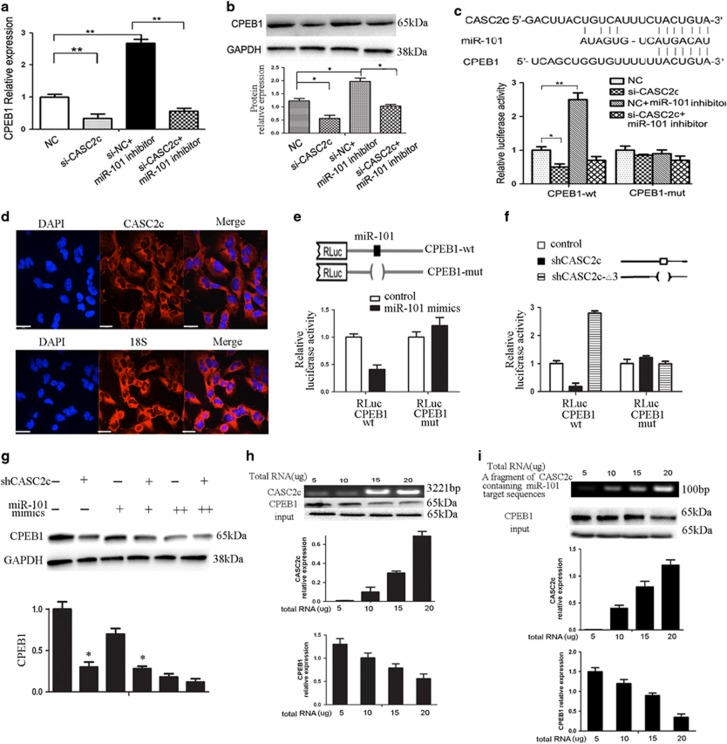
CASC2c competes to combine miR-101 by repelling CPEB1. (a or b) The expression of miR-101 was analyzed through real-time qPCR (a) and western blot (b) in si-CASC2c, miRNA-101 inhibitor or miRNA-101 inhibitor-transfected U251 cells. Data presented as mean±S.E.M. of three independent experiments; *P<0.05, **P<0.01. (c) Upper, nucleotide resolution of miRNA-binding sites in CASC2c and CPEB1. Below, relative fluorescence activity in U251 cells co-transfected with pMIR-REPORT-WT/mutant 3′-UTR CPEB1 and miR-101 inhibitor or negative control, pMIR-REPORT-WT/mutant 3′-UTR CPEB1, si-CASC2c and miR-101. Data presented as mean±S.E.M. of three independent experiments; *P<0.05, **P<0.01. (d) RNA fluorescence in situ hybridization showing the localization of CASC2c, the nucleus is counterstained with DAPI. Scale bar, 29μm. (e) Relative fluorescence activity in U251 cells co-transfected with RLuc-CPEB1-wt or RLuc-CPEB1-mut and miR-101 ncor miR-101 mimics. Data presented as mean ±S.E.M. of three independent experiments; *P<0.05, **P<0.01. (f) Relative fluorescence activity in U251 cells co-transfected with RLuc-CPEB1-wt or RLuc-CPEB1-mut and shCASC2c or shCASC2c-△3 plasmid. Data presented as mean±S.E.M. of three independent experiments; *P<0.05, **P<0.01. (g) The expression of CPEB1 was analyzed through western blot in U251 cells transfected with different combinations of shCASC2c and miR-101 mimics. (+) corresponds to 1.5 mg shCASC2c and to 40 ng of miR-101 mimics, whereas (++) corresponds to 200 ng of miR-101 mimics. Data presented as mean±S.E.M. of three independent experiments; *P<0.05. (h) The expression of CASC2c and CPEB1 was detected by real-time qPCR and western blot in U251 cells after adding variant amount of CASC2c into miR-101-CPEB1 reaction mixture. Data presented as mean±S.E.M. of three independent experiments. (i) The expression of CASC2c and CPEB1 was detected by real-time qPCR and western blot in U251 cells after adding variant amount of the fragment of CASC2c that containing miR-101 target sequences into miR-101-CPEB1 reaction mixture. Data presented as mean±S.E.M. of three independent experiments